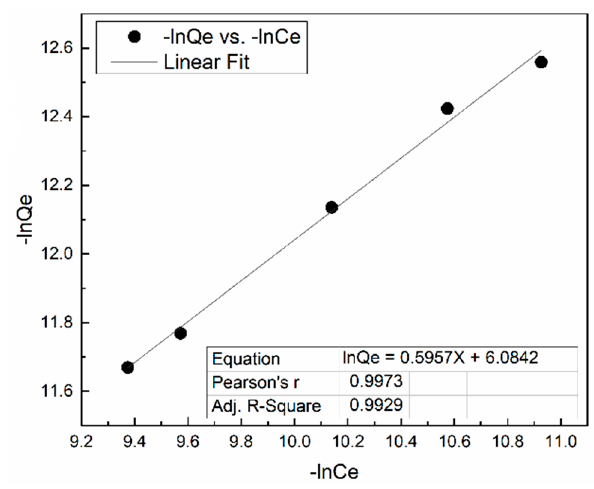
Figure 8. Linear regression analysis of data using the Freundlich adsorption isotherm.